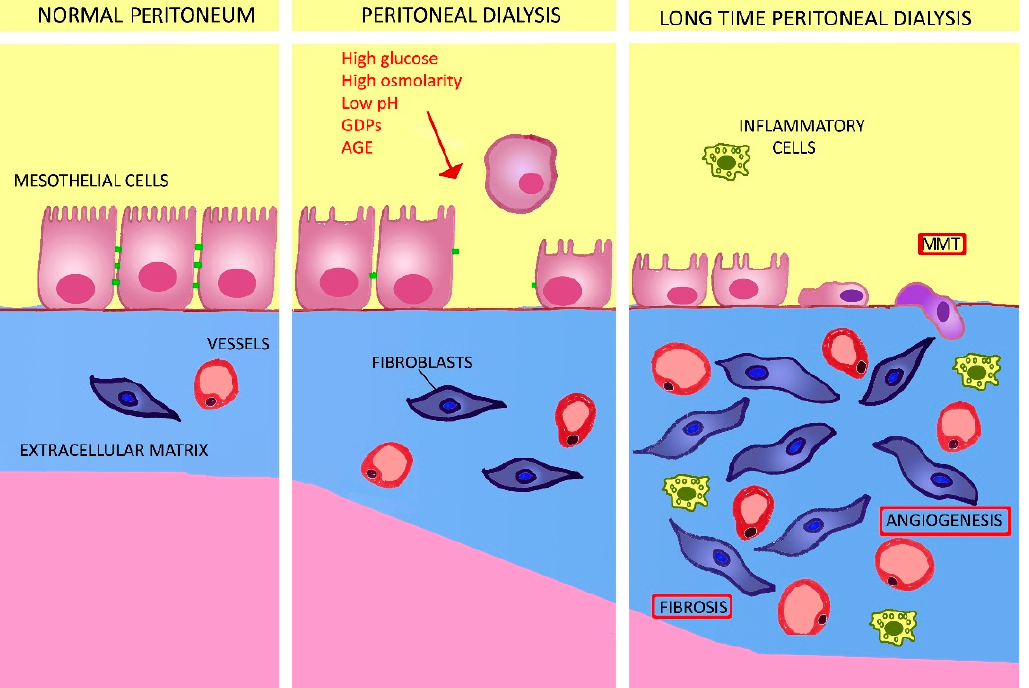
Figure 1. Schematic representation of a cross-section of the peritoneum during PD. The left-hand panel shows a normal peritoneal membrane. During PD, a series of deleterious factors injure the mesothelium (middle panel) with a consequent loss of the brush border, loss of cell-to-cell contact structure, and cell detachment from the basement membrane. Moreover, in response to cytokines and growth factors, fibroblasts are activated to myofibroblasts, which increase the secreted extracellular matrix. In long-term PD, there is significant damage to the mesothelial layer (right-hand panel), and mesothelial cells undergo MMT, thus contributing to the expansion of fibrosis. Inflammatory cells are also recruited and a neoangiogenic response is activated, leading to ultrafiltration failure. Abbreviations: GDPs: glucose-degradation products; AGE: advanced glycosylation end product; MMT: mesothelial-to-mesenchymal transition.